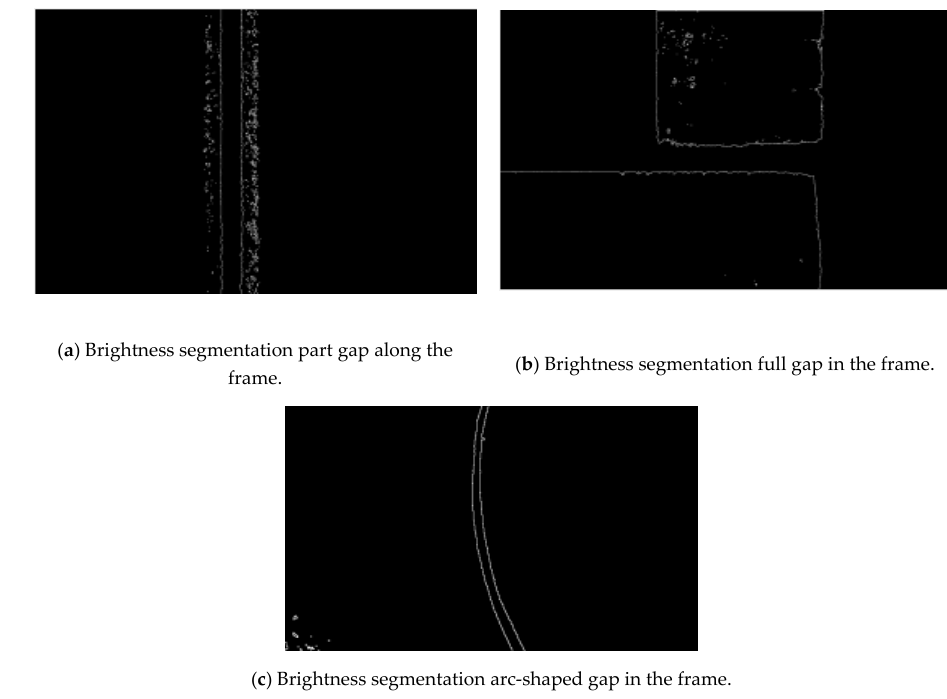
Figure 13. The result of brightness segmentation of the gap of the welded workpieces.